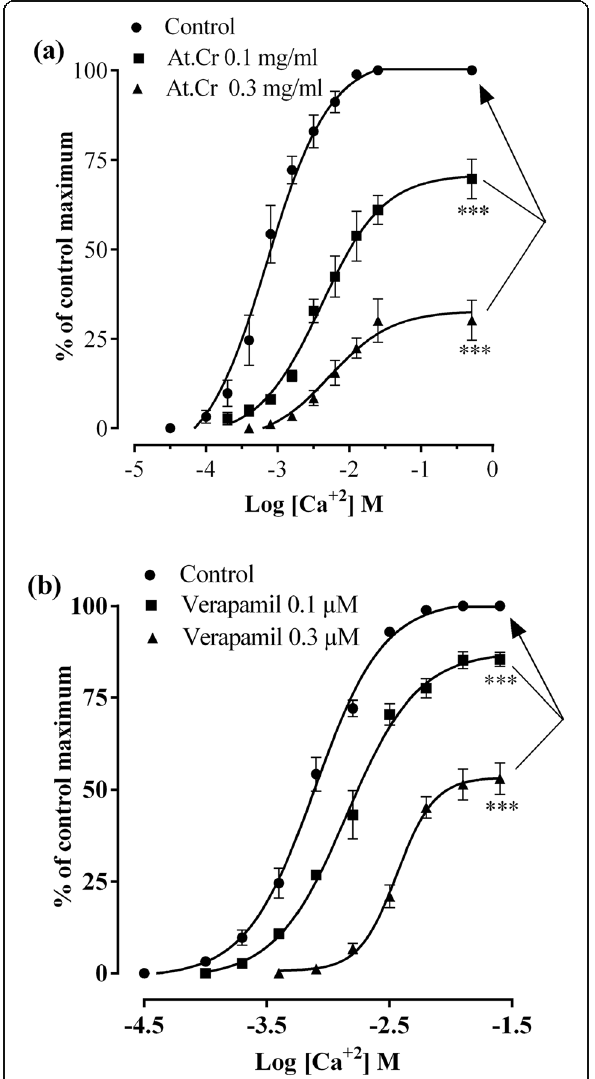
Fig. 5 Effects of ( a ) Asphodelus tenuifolius crude extract (At.Cr) and ( b ) verapamil upon Ca +2 concentration response curves in jejunum preparations. *** p < 0.001 as analyzed by two way ANOVA followed by Dunnett ’ s test. Values are mean ± SEM ( n = 5)